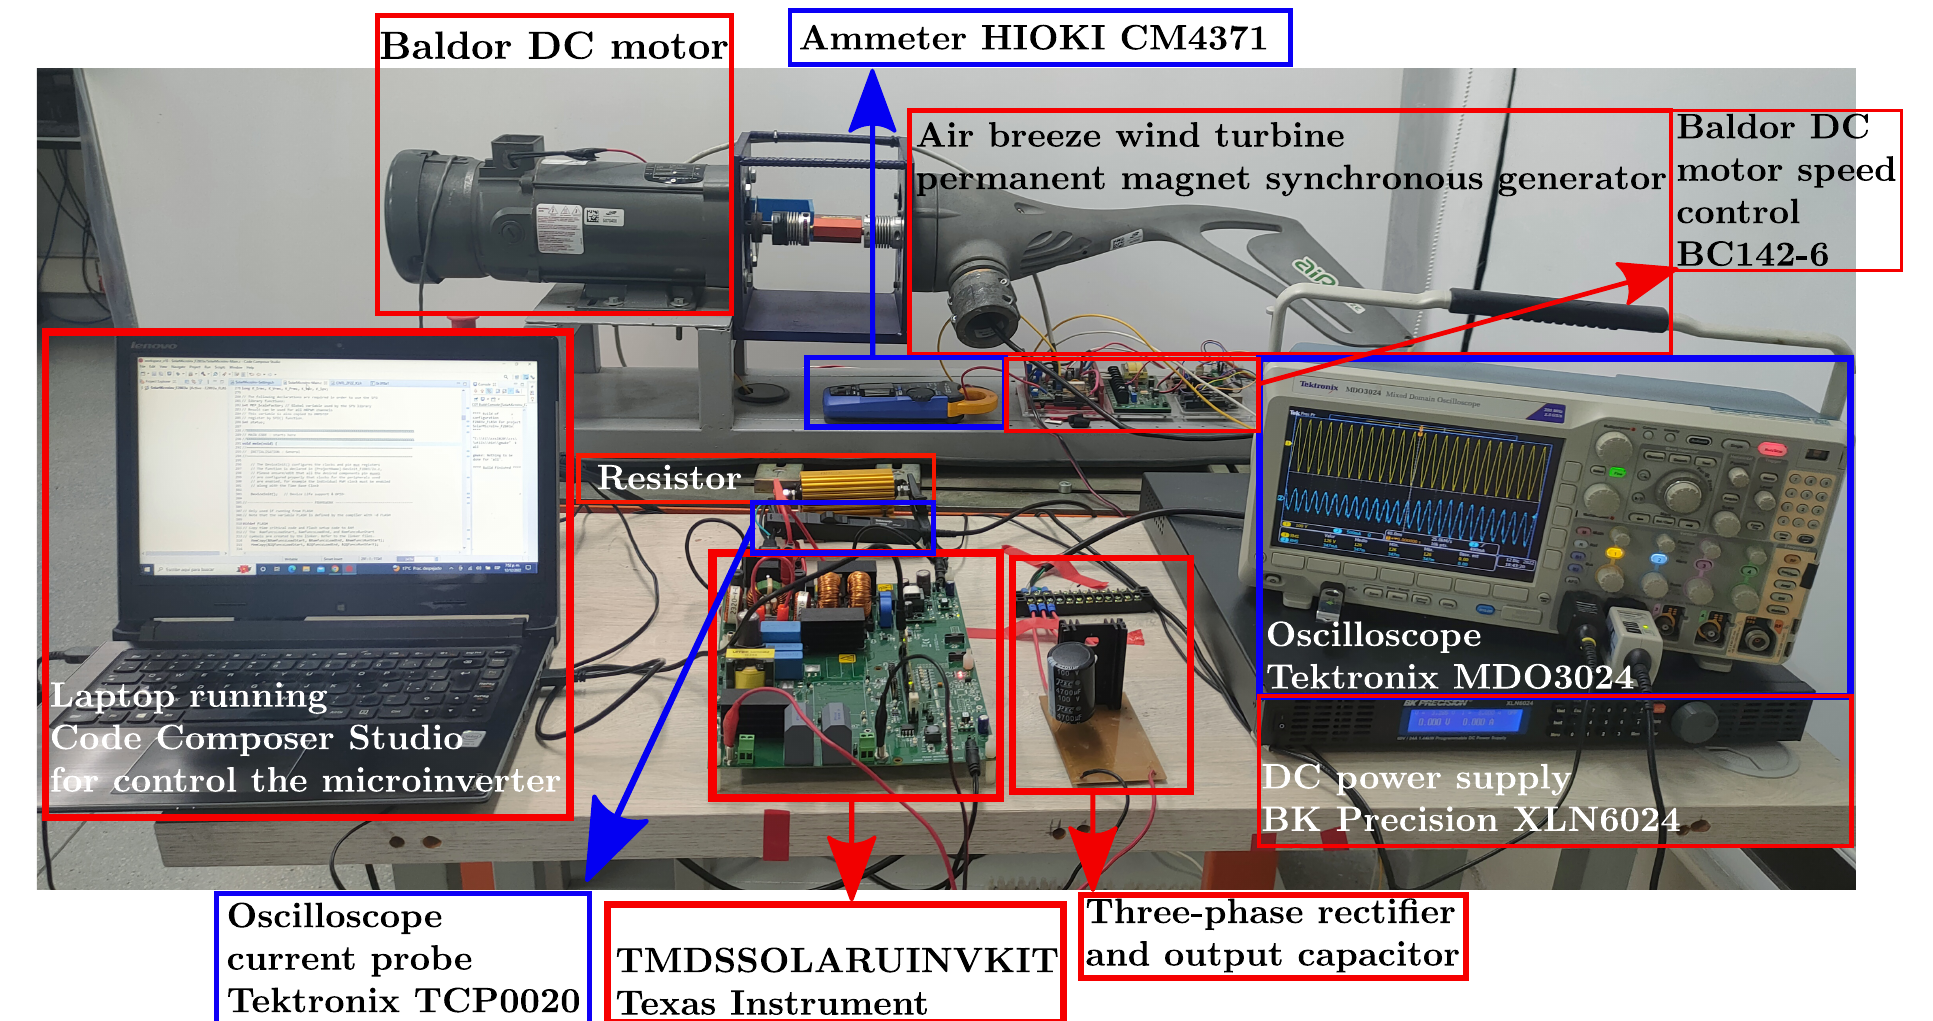
Figure A2. Experimental test bench of the small wind generation